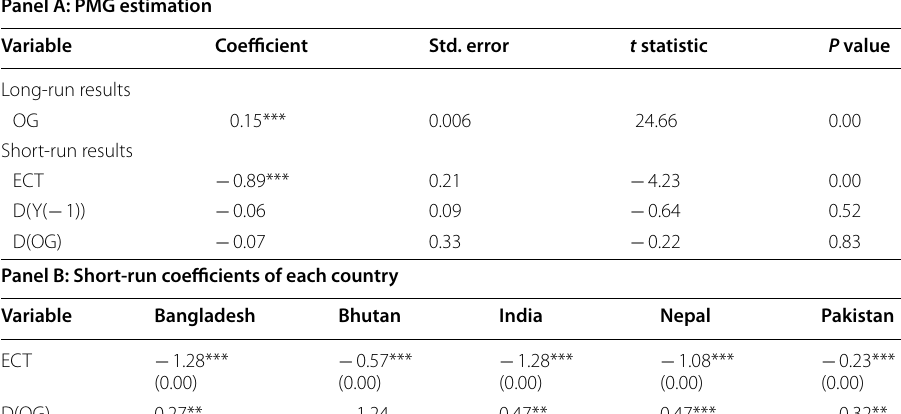
Table 3 PMG estimation of ARDL (2,1) for model